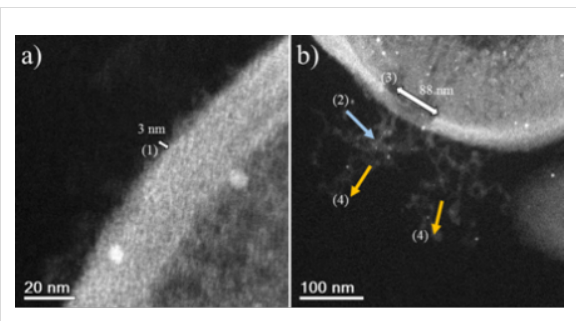
Figure 8: MRSA STEM images. (a) (1) WTAs and CWGs ( ≈ 3 nm). (b) (2) AgNPs interacting with CWGs. (3) Membrane destabilization ( ≈ 88 nm). (4) Cytoplasmic leakage. The Ag nanoparticle concentration is 23 ppm.